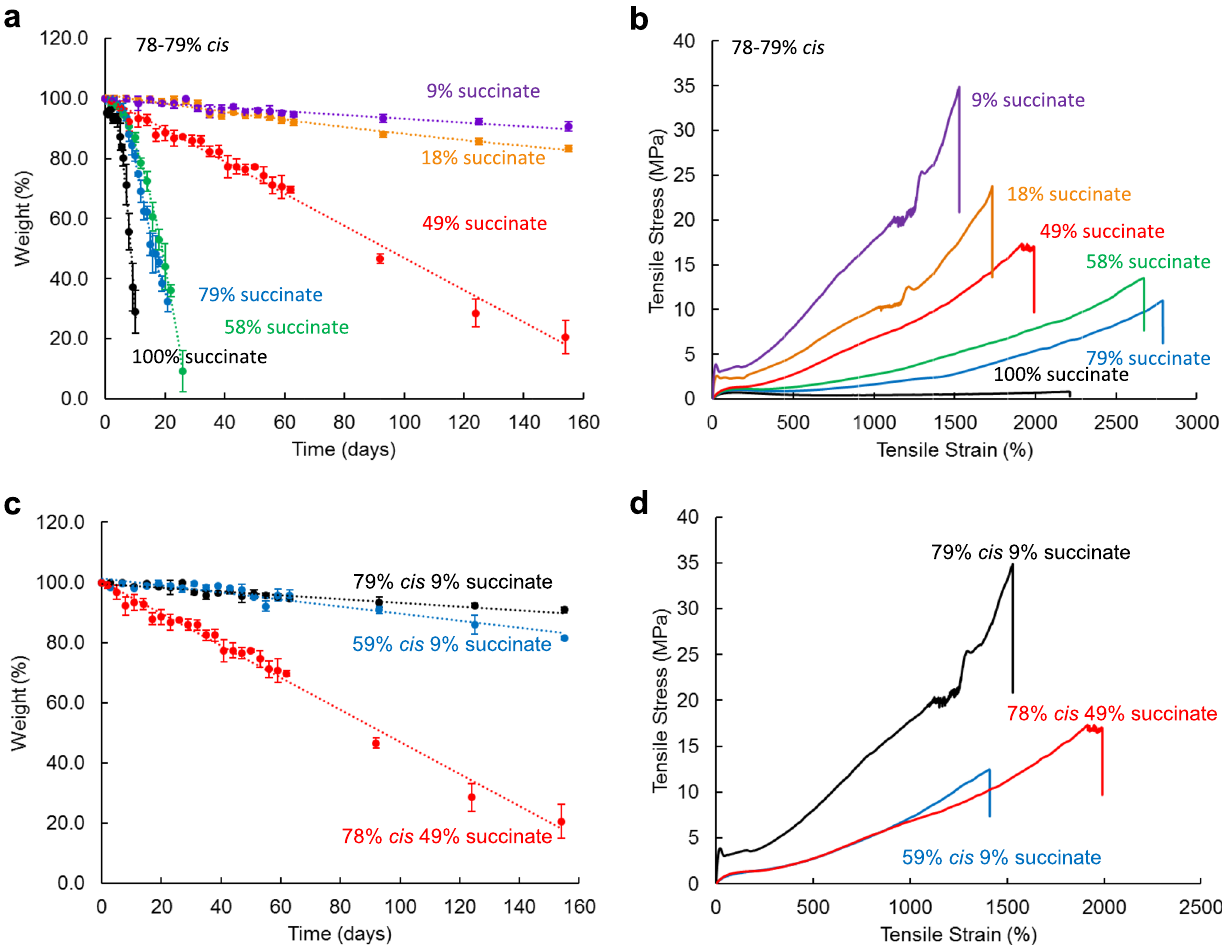
Fig. 2 Compositional-dependent mechanical properties of the resorbable polymers. A Mass loss as a function bis(3-mercaptopropyl) succinate ( 2 ) stoichiometry over time in a series of high cis (78 – 79%) elastomers show compositionally dependent linear surface erosion behavior. B Increasing the amount of bis(3-mercaptopropyl) succinate ( 2 ) which is a longer, bulkier comonomer reduced the UTS of the resulting elastomers. Mechanical properties and degradation rates are highly tunable depending on the amount of cis -alkene bonds in the backbone and stoichiometric control of succinate content. Succinate groups in the chemical structure provide fl exibility and hydrophilicity to the polymer chains and facilitate the degradation process. The increase in chain mobility and hydrophilicity results in an increase in the number of degradable ester groups and hence the degradation rates ( C ) and a decrease of Young ’ s modulus ( D ). Increasing the cis- alkene content resulted in slower degradation rates and higher Young ’ s moduli values, decreased ultimate strain. Error bars represent one standard deviation of the mean ( n = 3).